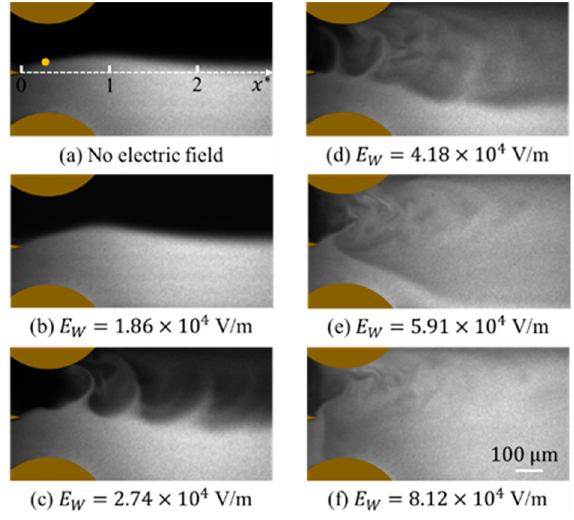
Figure 4. Flow visualization of the flow structures. The conductivity ratio of the two streams is 1:5000. The exposure time of the camera is 1 ms. The flow rate is 3 µ L/min for each stream. AC frequency of 130 kHz was applied in the w 0 = 650 µ m wide micromixer. ( a ) Without forcing. The yellow dot is the detection position in the following LIF measurements. It locates at x ∗ = 0.23 from the trailing